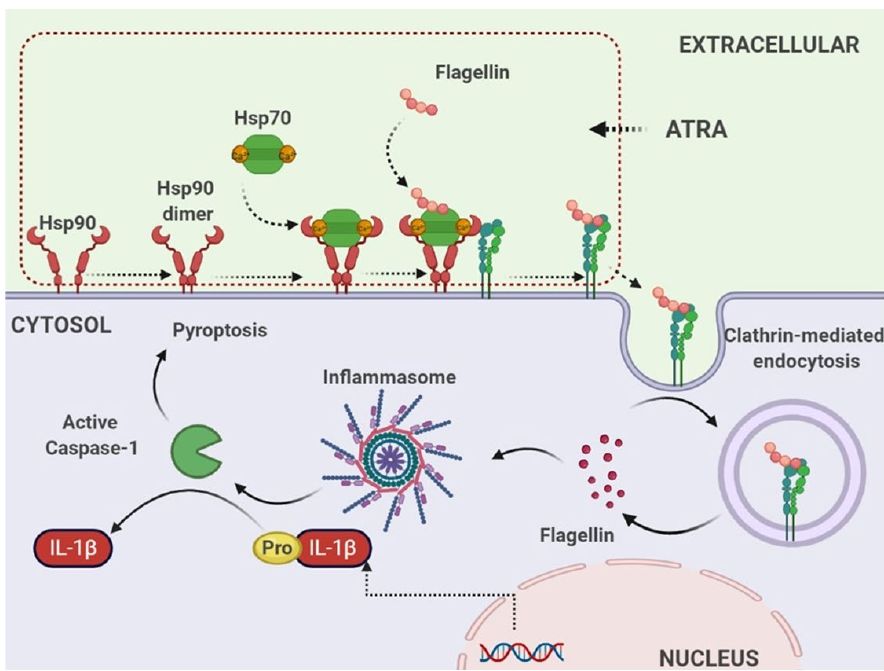
Figure 10. Proposed mechanism underlying the Hsp90/αMβ2 integrin complex-mediated flagellin internalization and intracellular recognition in human monocyte THP-1 cells treated with